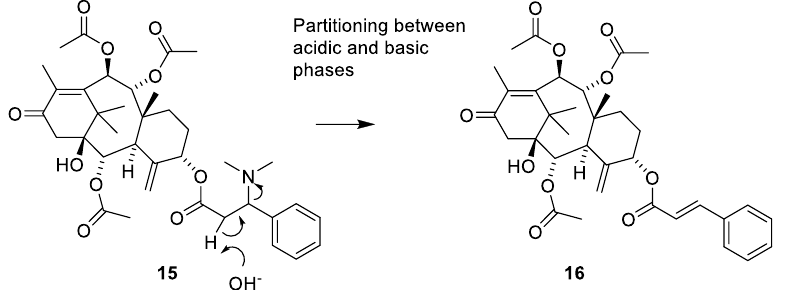
Figure 4. Structure elucidation of taxine I. During isolation, the dimethylamino group in diacetyltaxine B ( 15 ) is eliminated to give 16 . Solvation catalyzed with sodium methanolate affords the tetraol 17 (Figure 5). Hydrogenation afforded 18 [36]. Application of 1 H NMR spectroscopy confirmed the structure and enabled establishment of stereochemistry [35].